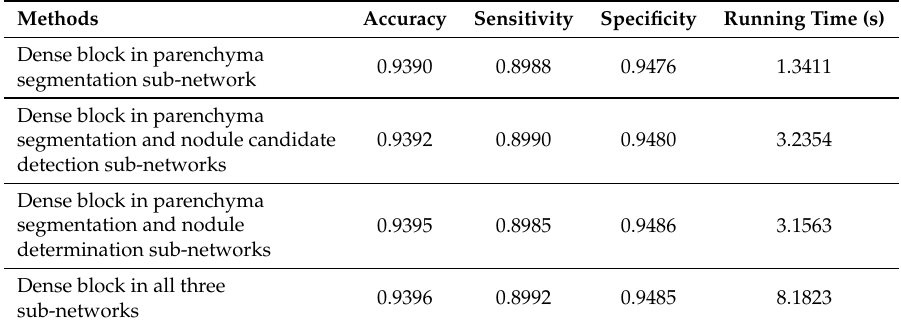
Table 8. Results of detecting pulmonary nodules and running time of using dense block in different sub-networks.